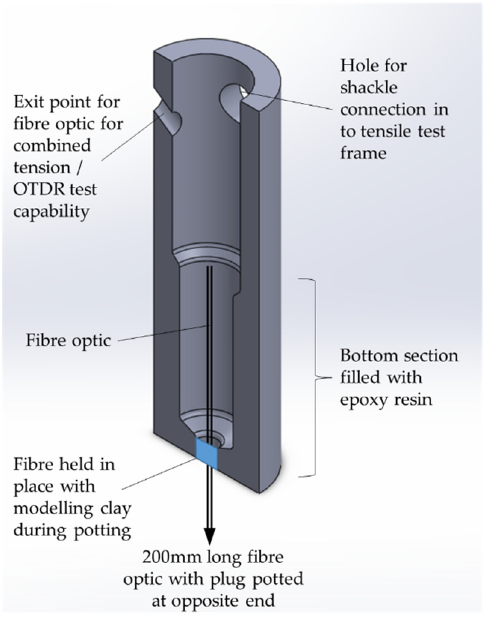
Figure 2. Collet design cutaway: dual-purpose design for both potting epoxy plugs onto fibre optics and securing fibre optics into tensile test machine for mechanical testing.